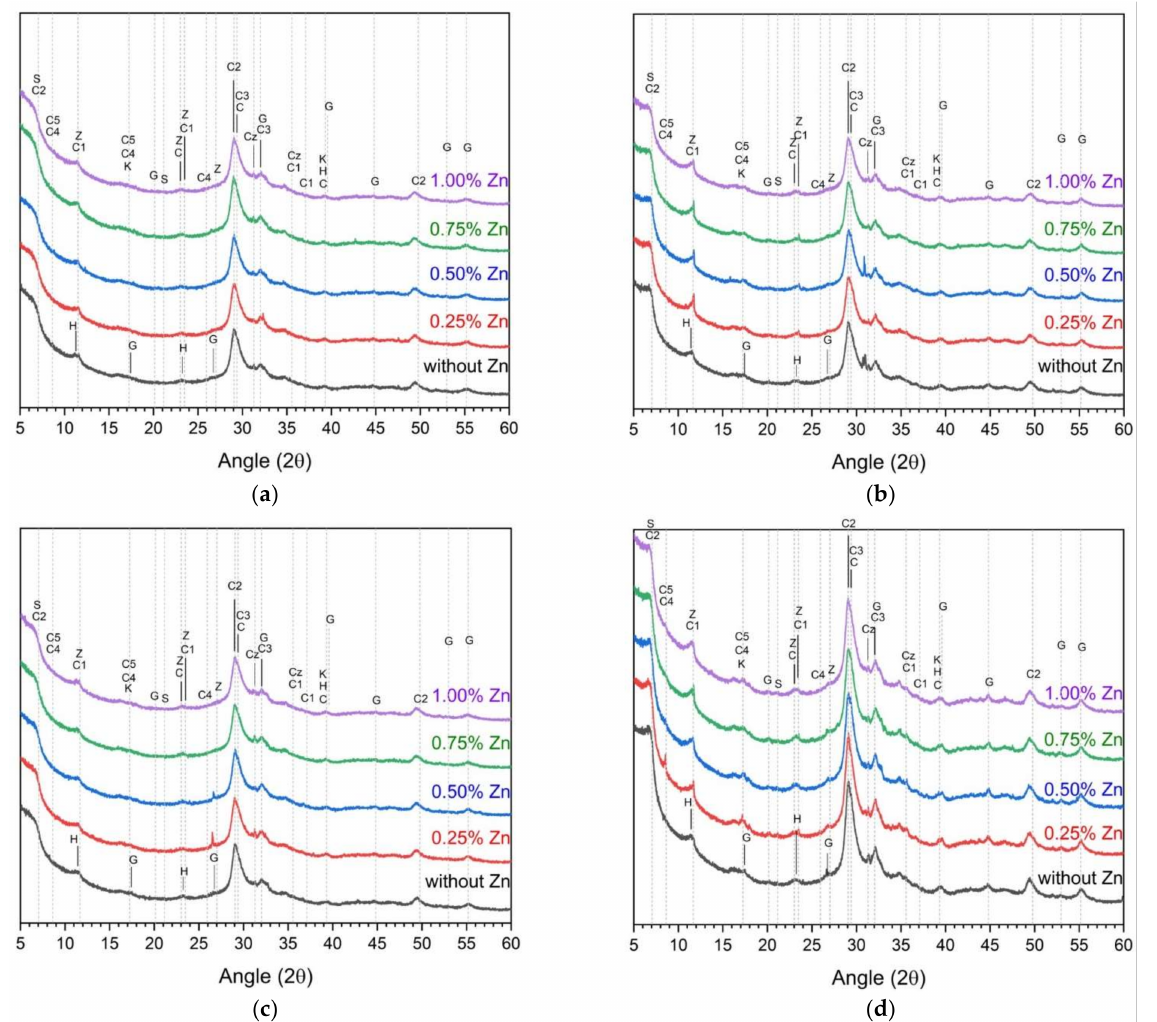
Figure 3. XRD analysis of samples with a w/b of 0.35 ( a ) cured at 23 ± 2 °C after 1 day, ( b ) cured at 23 ± 2 °C after 28 d, ( c ) cured at 40 ± 2 °C after 1 day, and ( d ) cured at 40 ± 2 °C after 28 d.